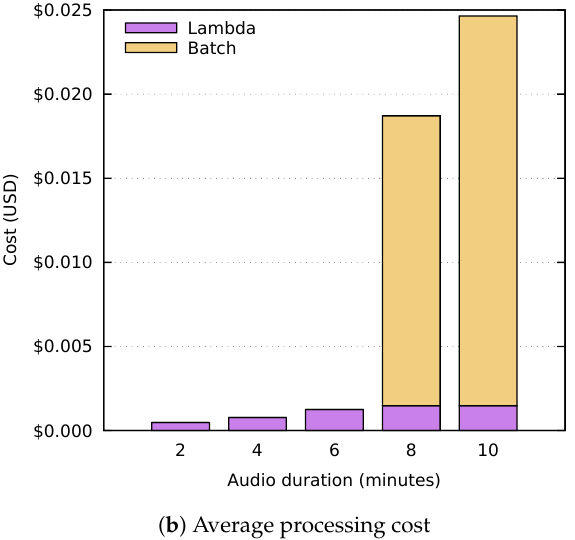
Figure 5. Time and cost analysis of the audio2srt function for different audio